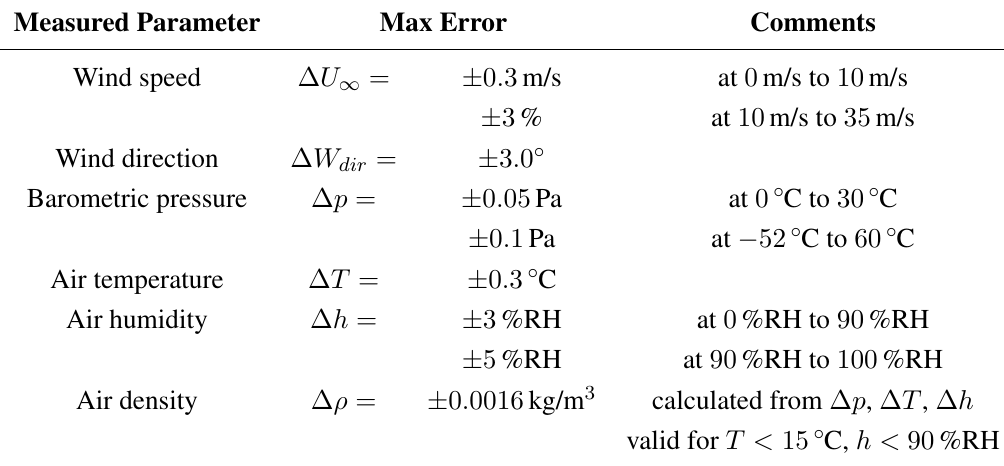
Table 3. Maximum error of the weather